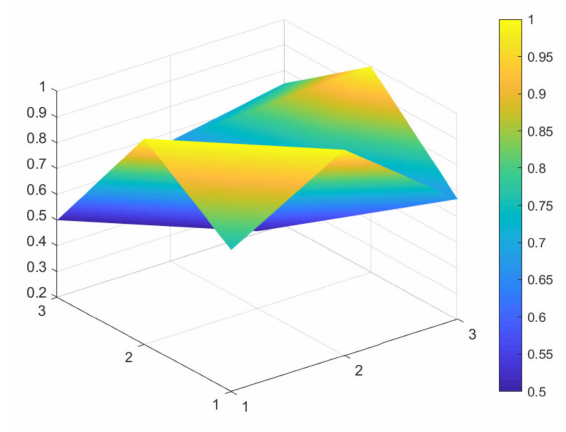
Figure 2. PMC-Surface chart of P11 (Excellent).